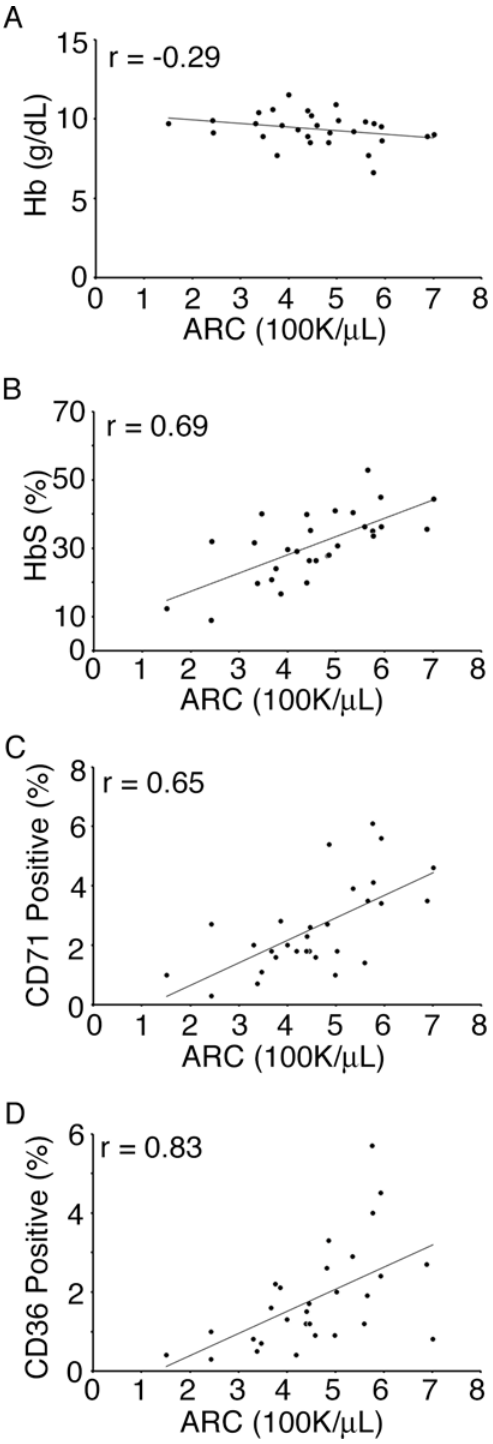
Fig 3. Analysis of ARC correlations. Values for A) hemoglobin [Hb (g/dL)], B) percentage of sickle hemoglobin [HbS (%)], C) percentage of reticulocytes with detected plasma membrane transferrin [CD71 (%)], and D) percentage of reticulocytes with detected plasma membrane thrombospondin receptor [CD36 (%)] are shown on the y-axis and plotted with the correlated absolute reticulocyte counts [ARC (100K/ μ L)] on the x-axis of each panel. Linear trend lines and correlation coefficients (r) are